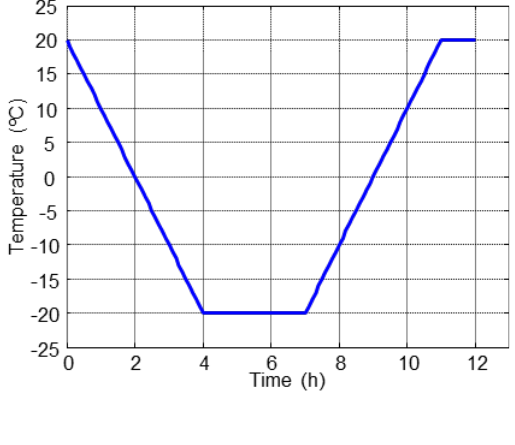
Figure 4. Accelerate freeze-thaw